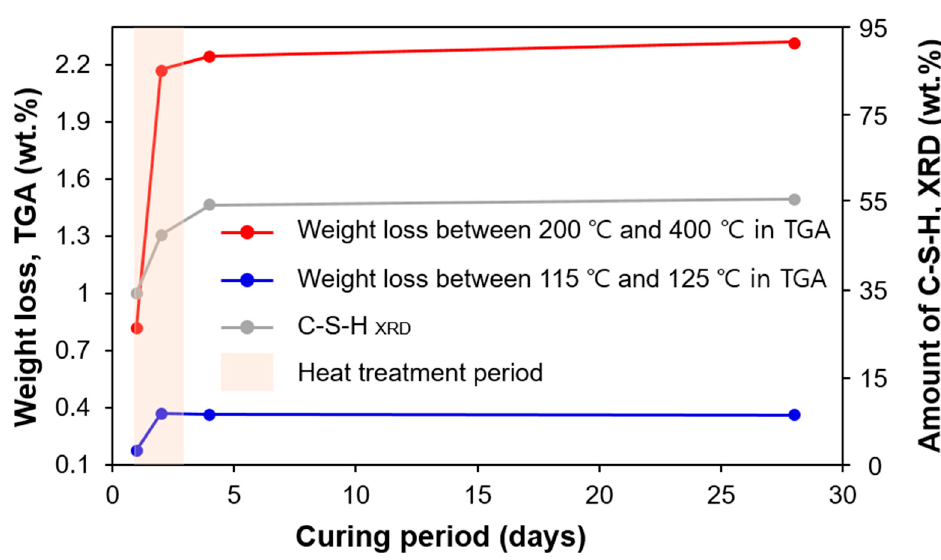
Figure 10. Comparison of C-S-H formation measured from XRD and TGA .